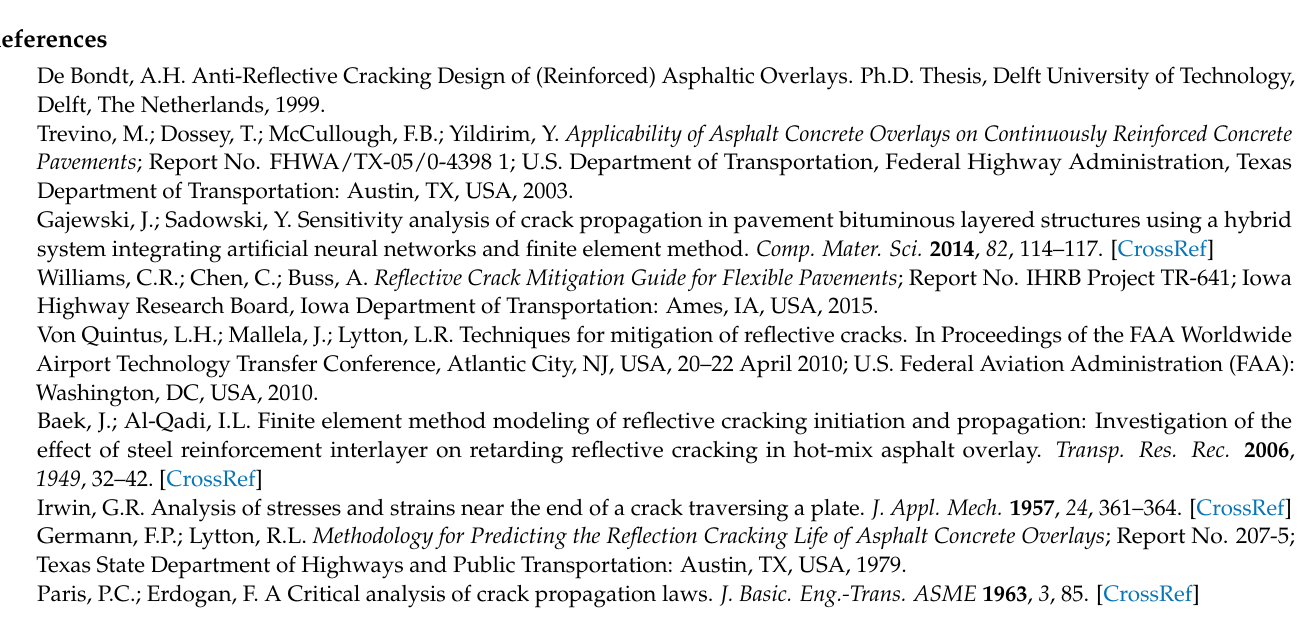
Figure S2: Apparatus to produce asphalt rubber at the laboratory; Figure S3: Asphalt rubber produc- tion.; Figure S4: Flowchart of the experimental program; Figure S5: Asphalt mixtures production; Figure S6: Roller and slab; Figure S7: Samples obtaining; Figure S8: Schematic representation of the finite elements model; Figure S3 Figure S9: Horizontal and vertical displacements; Figure S10: Hor- izontal and vertical strains; Figure S11: Distortion and Von Mises strain; Figure S12: Vertical and horizontal tension; Table S1: Annual traffic; Table S2: Overlay monthly damage; Table S3: RCD test results; Table S4: Von Mises strains; Additional details about Asphalt rubber production, asphalt mixtures production and numerical simulation